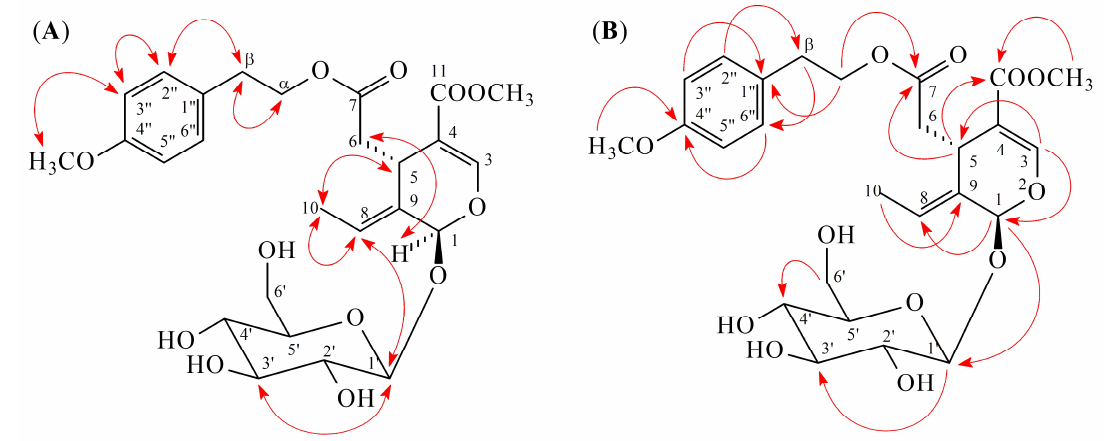
Figure 2. Key NOESY ( A ) and HMBC ( B ) correlations of 1 . Table 1. 1 H-NMR data for compounds 1 – 3 (δ in ppm, J in Hz).